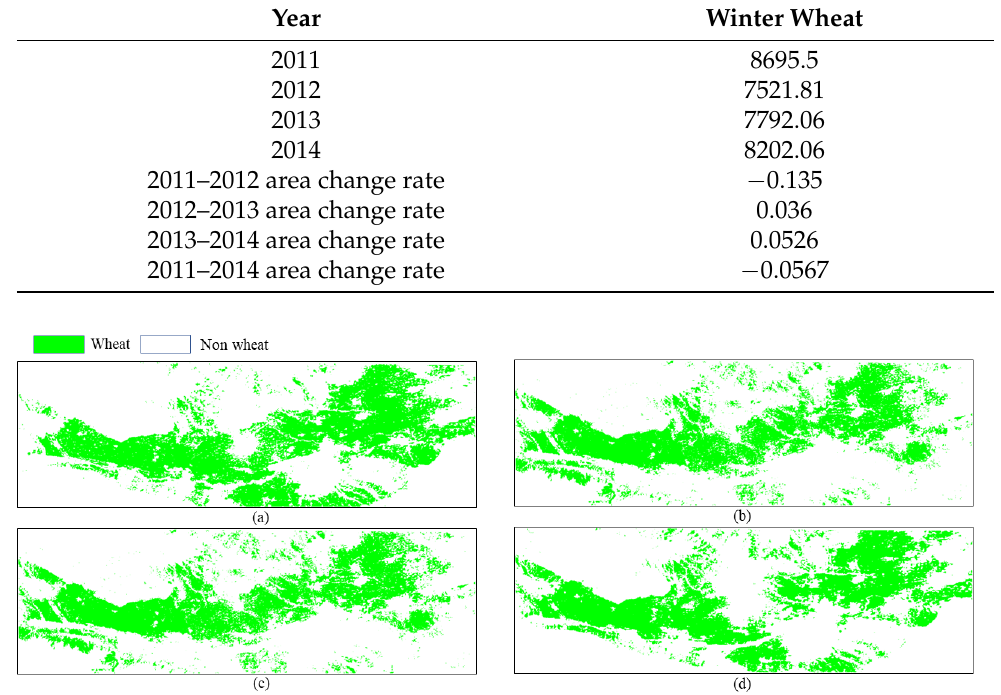
Figure 12. Distribution and change of winter wheat in the study area from 2011 to 2014. ( a ) Wheat distribution map in 2011. ( b ) Wheat distribution map in 2012. ( c ) Wheat distribution map in 2013. ( d ) Wheat distribution map in